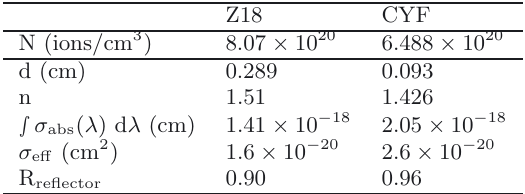
Fig. 2. Experimental setup (a) for the 1.5 μ m → Visible, NIR absolute conversion efficiency of studied samples; (b) for the photocurrent measurement in the bifacial c-Si solar cell gener- ated by sub bandgap excitation of an upconverter material. Table 1. Relevant parameters used for short – circuit current calculations (the effective absorption cross-section is calculated by integrating σ λ (abs) ( 4 I 15 / 2 → 4 I 13 / 2 ) over in the spectral range corresponding to the FWHM of the excitation laser